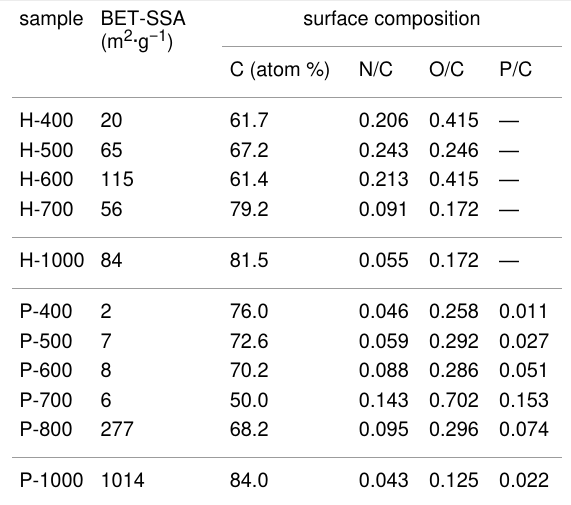
Table 1: Surface properties of H- and P-type precursors (for the naming scheme of the samples see section